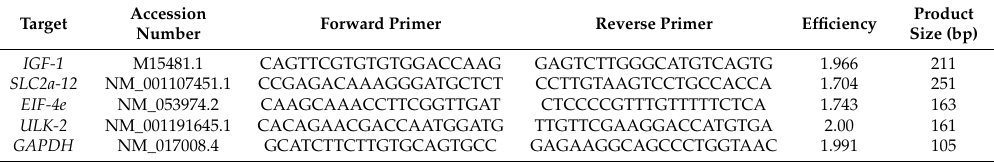
Table 6. Primer properties used in qRT-PCR for determination of transcript